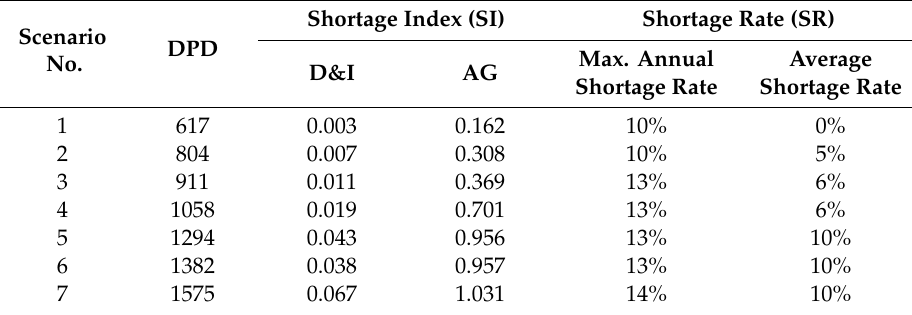
Table 5. Water shortage indices of di ff erent water shortage